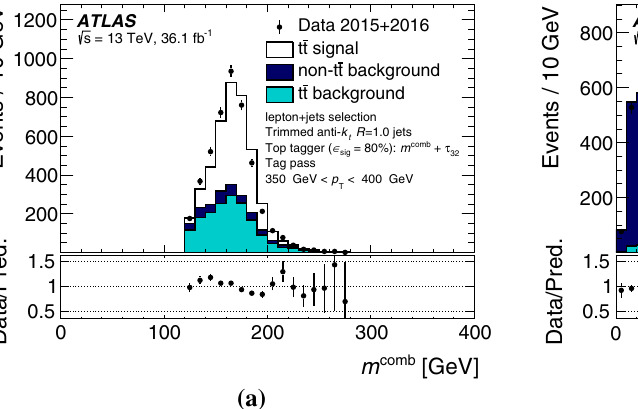
Fig. 16 The anti- k t trimmed jet mass distribution in the pass ( a ) and fail ( b ) categories for the m comb + τ 32 top-quark tagger working point after the chi-square fit has been performed. The templates shown here arethoseusedinthechi-squarefitfortheextractionofthethreenormali-